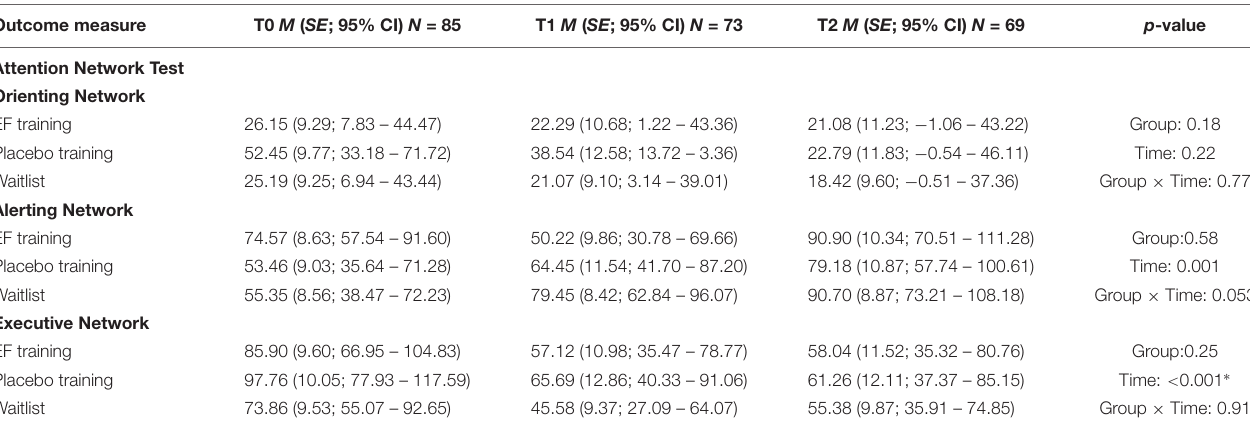
TABLE 3 | Baseline and follow-up data on the Attention Network Test for Children for the three treatment groups. Outcome